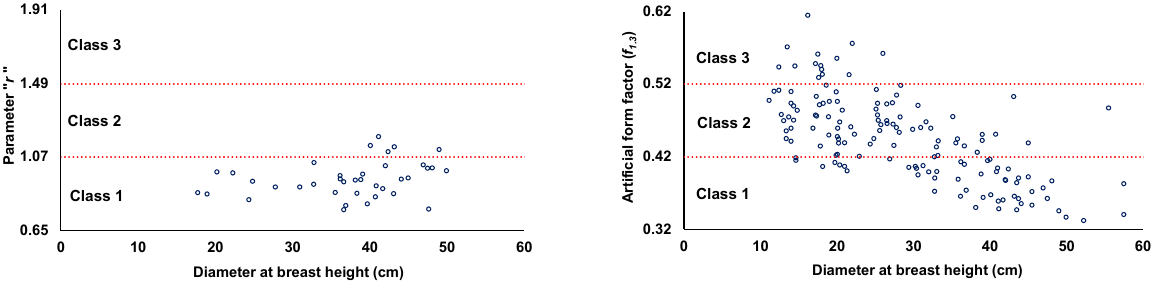
Figure 4. Stratification of the variables “ r ” and artificial form factor according to the diameter at breast height for Tectona grandis L.f., central-west region, Brazil.